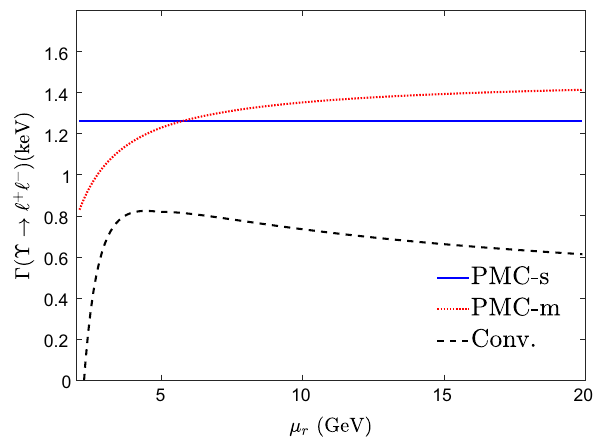
Fig. 2 The N 3 LO decay width for the ϒ( 1 S ) leptonic decay versus the renormalization scale μ r under the PMC-s, PMC-m and conventional scale-setting approaches